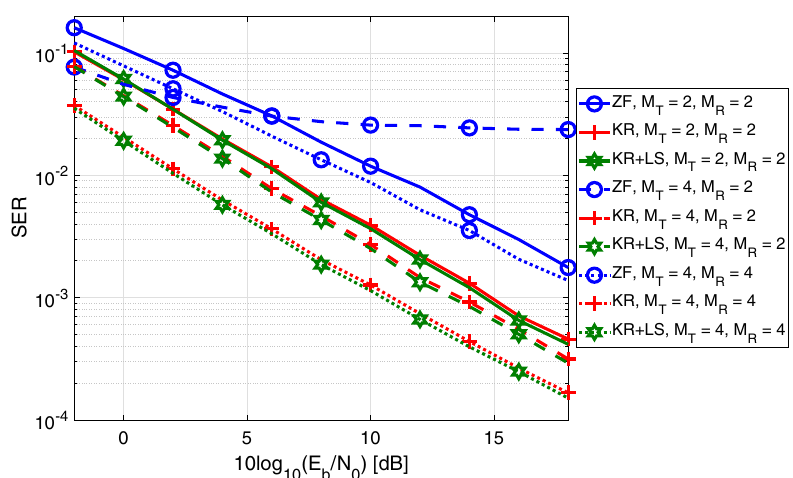
Fig. 4 SER comparison for different numbers of transmit and receive